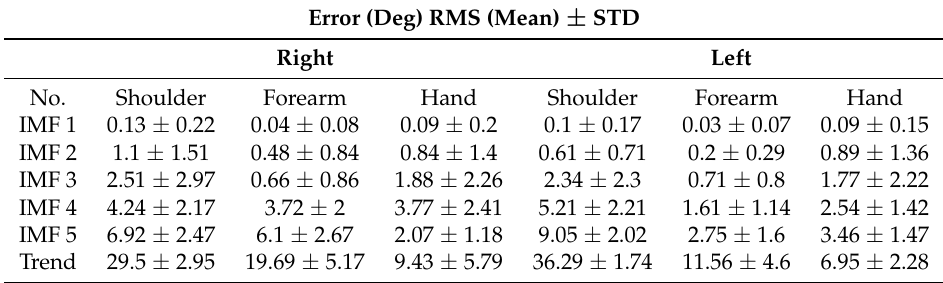
Table 6. Root mean squared errors of each frame for the decomposed IMFs and the trends of golf